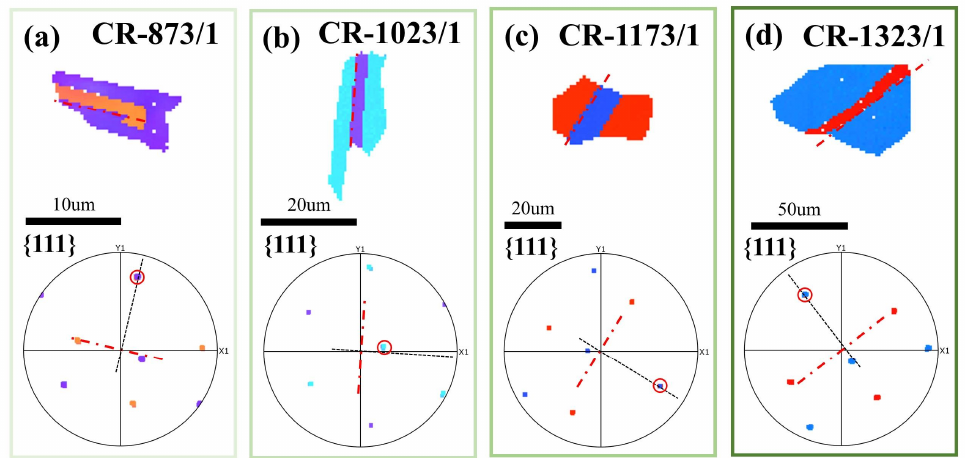
Figure 9. Twin boundaries’ characteristics analyzed by EBSD. The color‑coded grain orientation maps and {111} plane polar diagram of the twins and the corresponding grains in Ni 2 CrFe alloys after annealing at different temperatures for 1 h. ( a ) CR‑873/1; ( b ) CR‑1023/1; ( c ) CR‑1173/1; ( d ) CR‑1323/1.